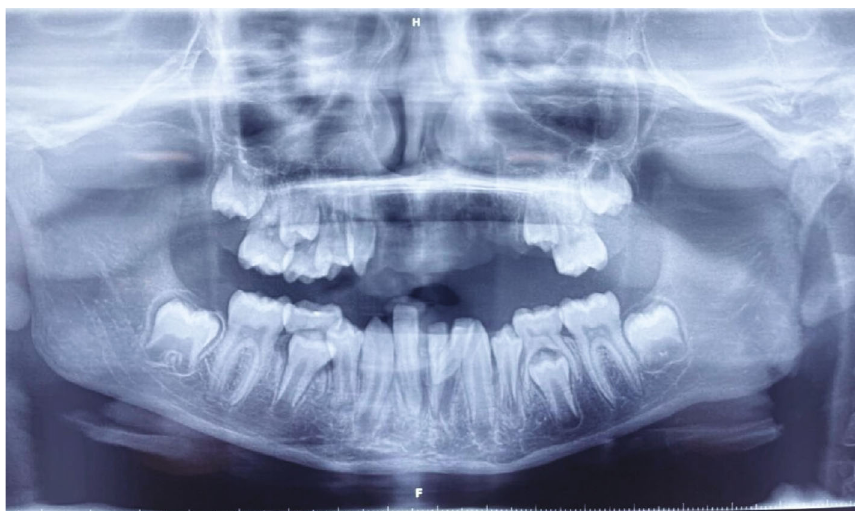
Figure 4: Radiograph showing multiple avulsions of the